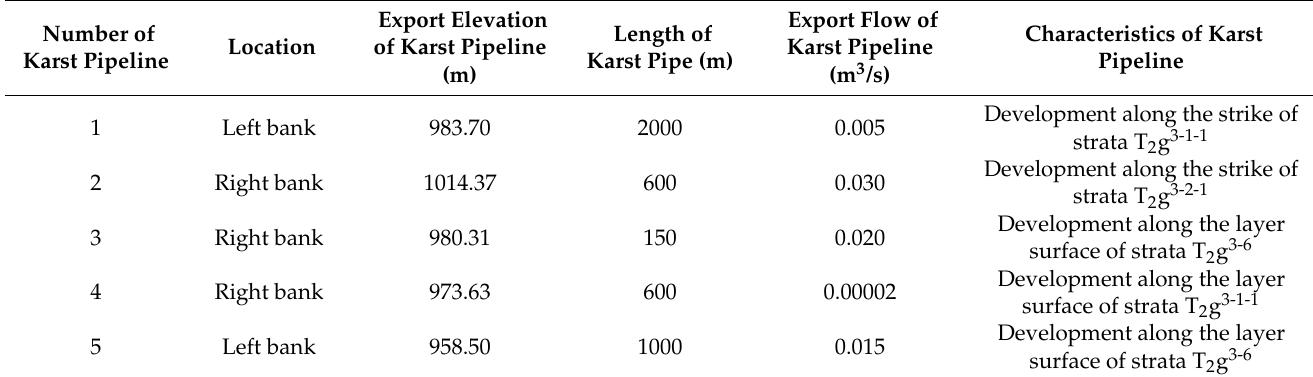
Figure 3. Groundwater contour map of dam site area under natural conditions. Table 4. Characteristics of karst pipe at dam